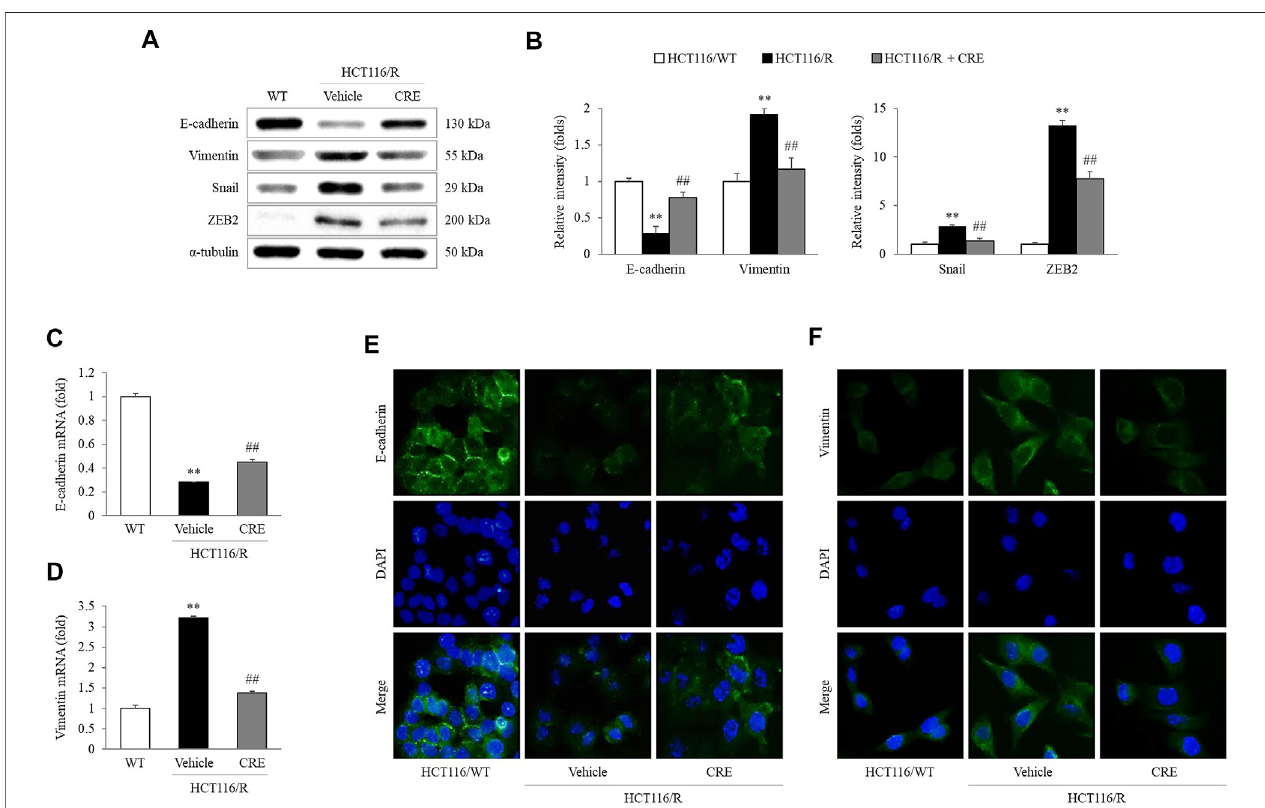
FIGURE 4 | CRE reversed EMT in HCT116/R cells. EMT-related protein levels (A) and the corresponding intensities were quanti fi ed (B) . Gene expression levels of E-cadherin and vimentin were measured in HCT116/WT and HCT116/R cells (C,D) . The expression levels of E-cadherin and vimentin were visualized by fl uorescence microscopy (E,F) . The data are expressed as the mean ± SD value ( n = 3). ** p < 0.01, compared to HCT116/WT cells. ## p < 0.01 compared to HCT116/R